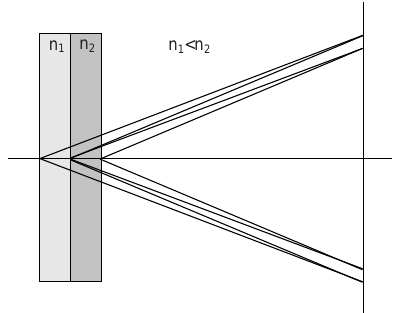
Figure 4. Belle-II PID system in the forward direction: prin- ciple of operation of the proximity focusing RICH with a non- homogeneous aerogel radiator in the focusing